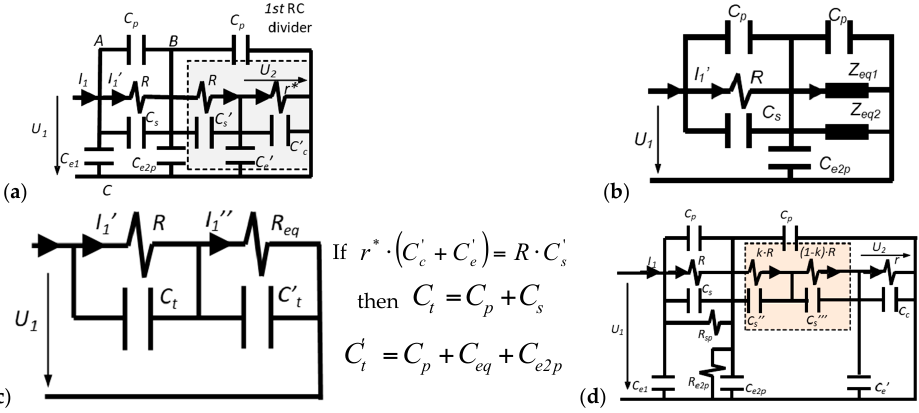
Figure 3. Equivalent electric schemes: ( a ) simplified divider model; ( b ) equivalent circuit replacing the 1st RC divider by two impedances in parallel Z eq 1 and Z eq 2 ; ( c ) equivalent model 2nd RC divider; ( d ) improved divider model analyzed in Section 4.